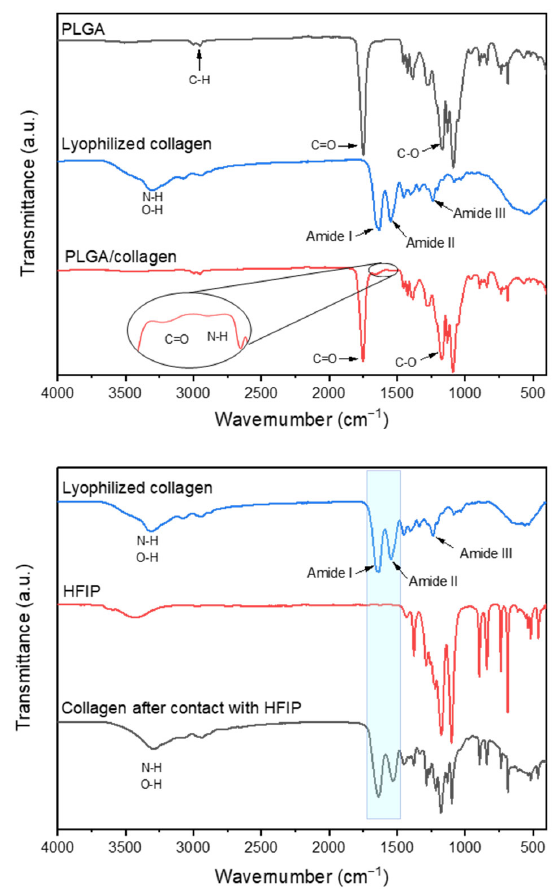
Figure 3. Fourier transform infrared spectroscopy (FTIR) spectra of PLGA, PLGA/collagen scaffolds, lyophilized collagen, and collagen prepared by solvent casting in HFIP.